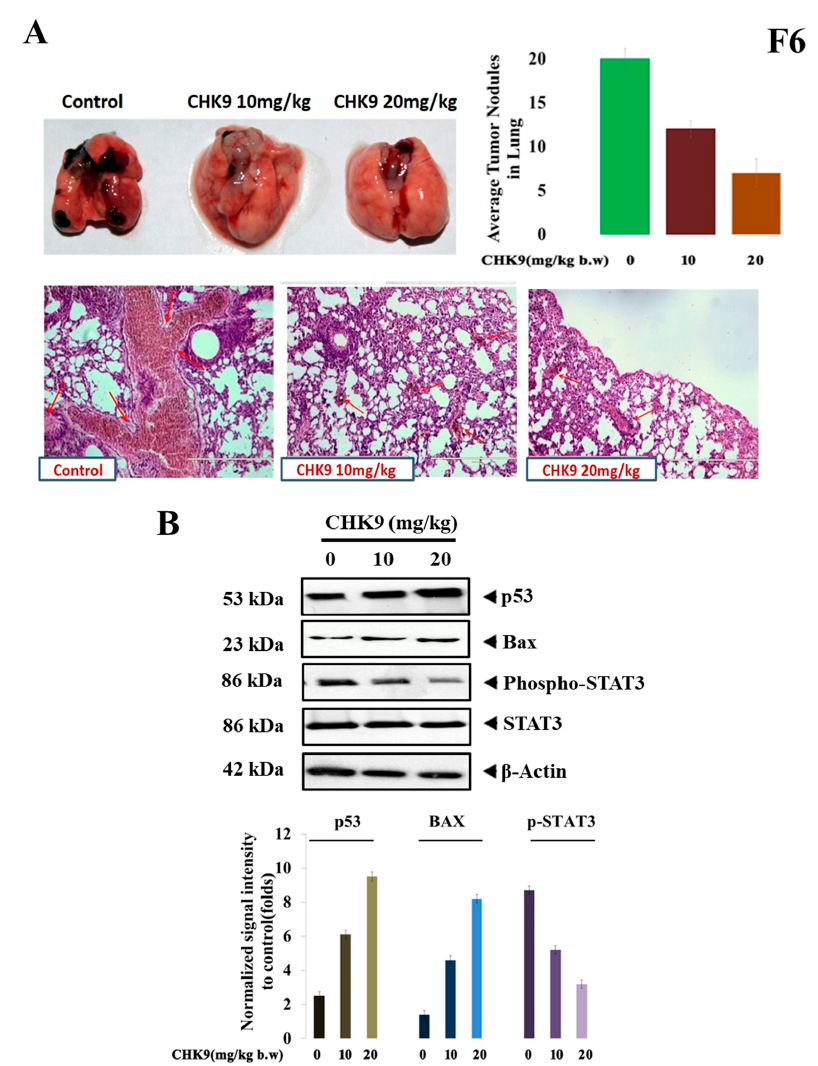
Figure 6. CHK9 inhibits colonization of LLC cells in animal models by inducing apoptosis. LLC cells (1 × 10 6 ) were tail vein injected into the BALB / c mice. Three groups of mice received 0, 10 and 20 mg / kg of CHK9 alternative days for 30 days and after 30 days of induction, lung exhibited tumor colonization (upper panel) H&E staining of the lung tissue exhibited tumor nodules (lower panel). ( A ) Graph representing the average number of tumor nodules of each group. ( B ) Western blotting studies demonstrate the expression of p53, Bax, phospho-STAT3, STAT3, and β -actin in CHK9 treated mice in a concentration-dependent manner and graphical representation of the relative normalized intensity of with respective loading